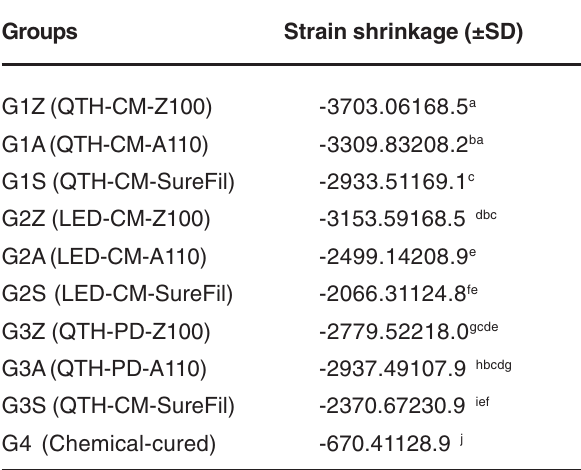
TABLE 3- Experimental groups and mean values of strain shrinkage (n=5) after 15 minutes ( µ strain)